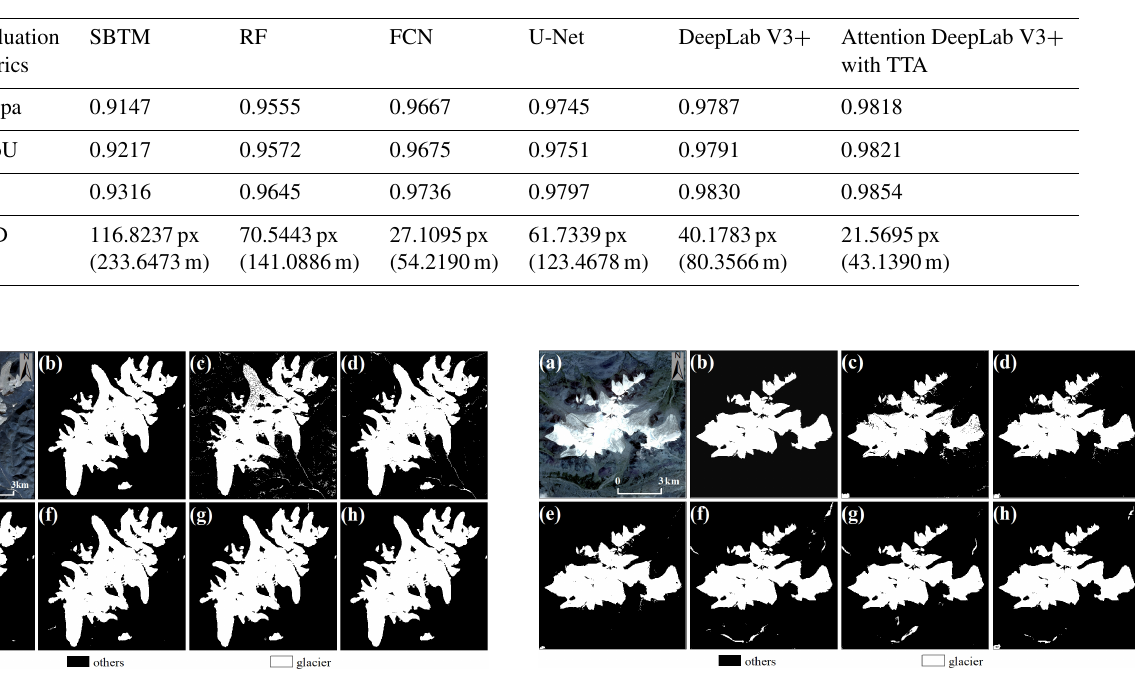
Figure 13. Demonstration of glacier extraction based on the im- age of 19 August 2020 (regional centroid coordinates of 32.96 ◦ N, 91.81 ◦ E). (a) The RGB image, (b) the ground truth, and (c) – (h) SBTM, RF, FCN, U-Net, DeepLab V3 + and Attention DeepLab V3 + with TTA,